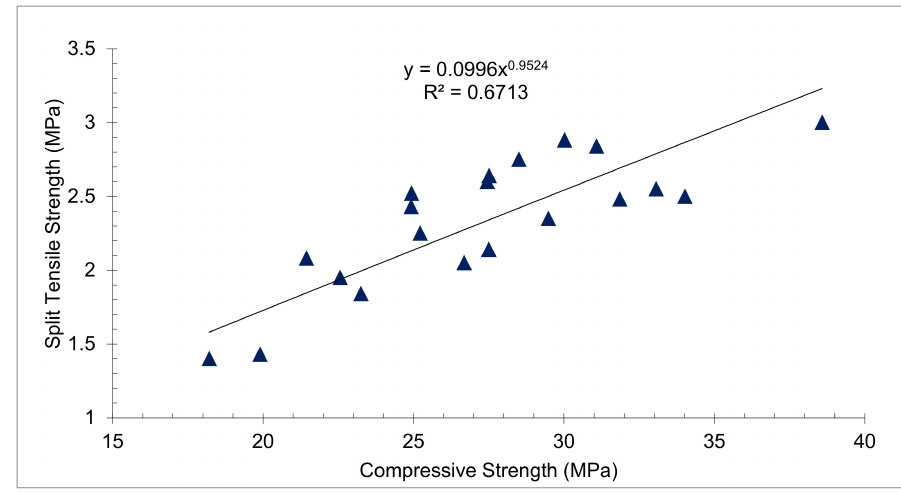
Figure 8. Linear Regression between Compressive and Tensile Strength: Data Source [54].